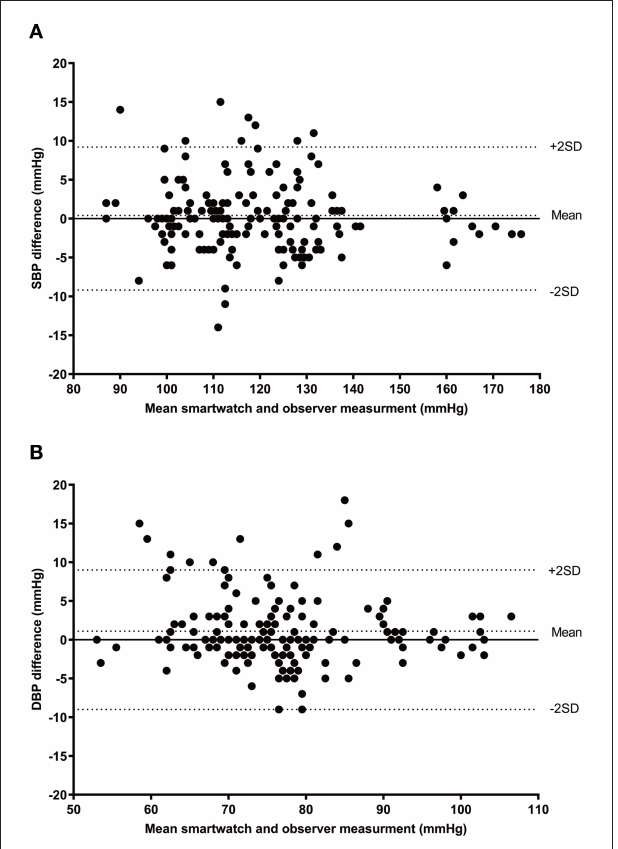
FIGURE 1 | Bland–Altman plots for the differences between the SM-R850 readings and the reference measurements for SBP (A) , and DBP (B) ( n = 168). SBP, systolic blood pressure; DBP, diastolic blood